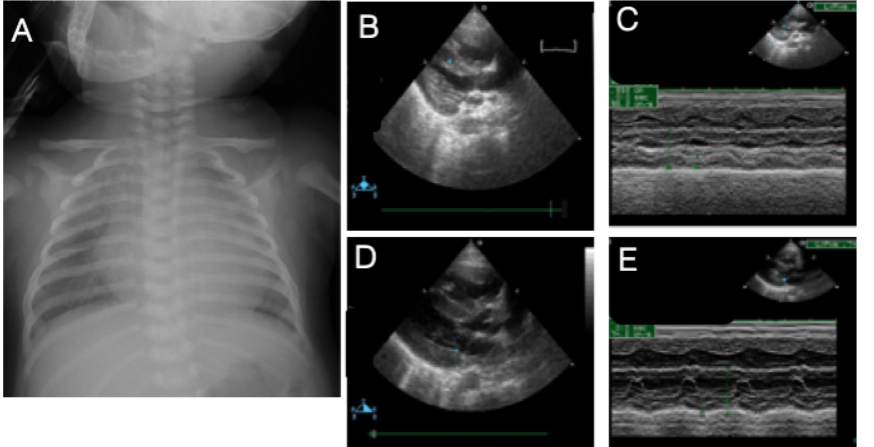
Figure 4. A 3-month-old female infant was diagnosed with pulmonary hypertension with high levels of renin and aldosterone syndrome. Chest radiography showed a mild ground glass appearance and cardiomegaly with a cardiothoracic ratio of 0.75 ( A ). Long-axis echocardiographic images (two- dimensional ( B ) and M-mode ( C )) demonstrated a hypertrophic right ventricle, which was much improved 6 months after candesartan (angiotensin receptor blocker) and captopril (angiotensin- converting enzyme inhibitor) were given ( D , E ).